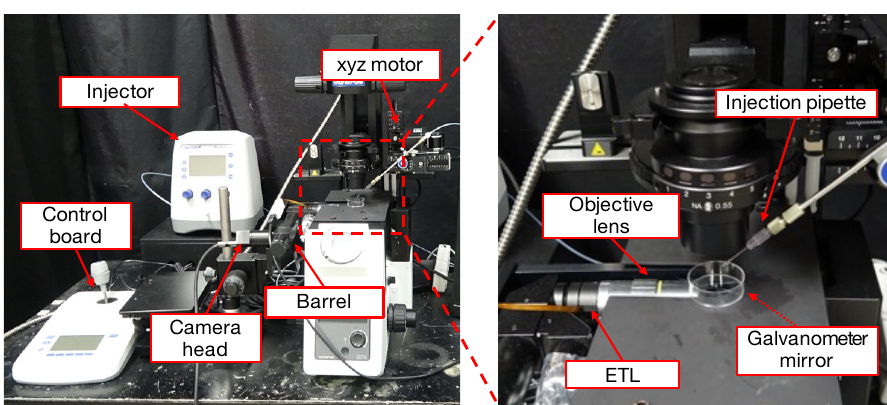
Figure 1. Configuration of the proposed system.